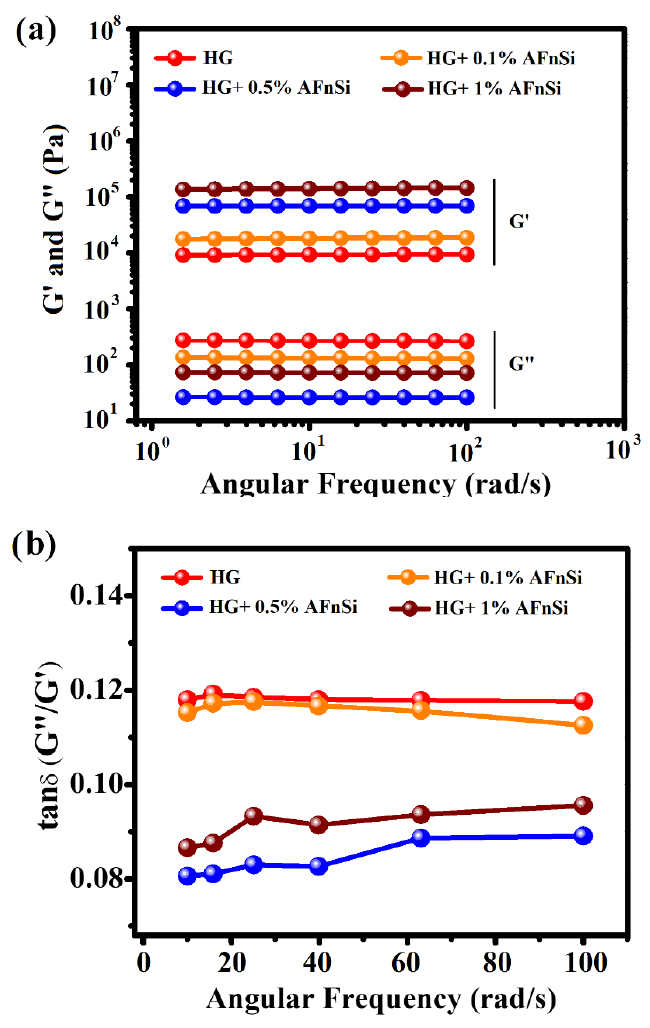
Figure 8. Storage modulus (G (cid:48) ) and loss modulus (G”) ( a ), and loss factor (Tan δ ) ( b ), as a function of the angular frequency ( ω ; rad/s) for the photocrosslinked HG hydrogel with different concentrations of AFnSi crosslinkers such as 0, 0.1, 0.5, and 1.0% ( w / v ), respectively.